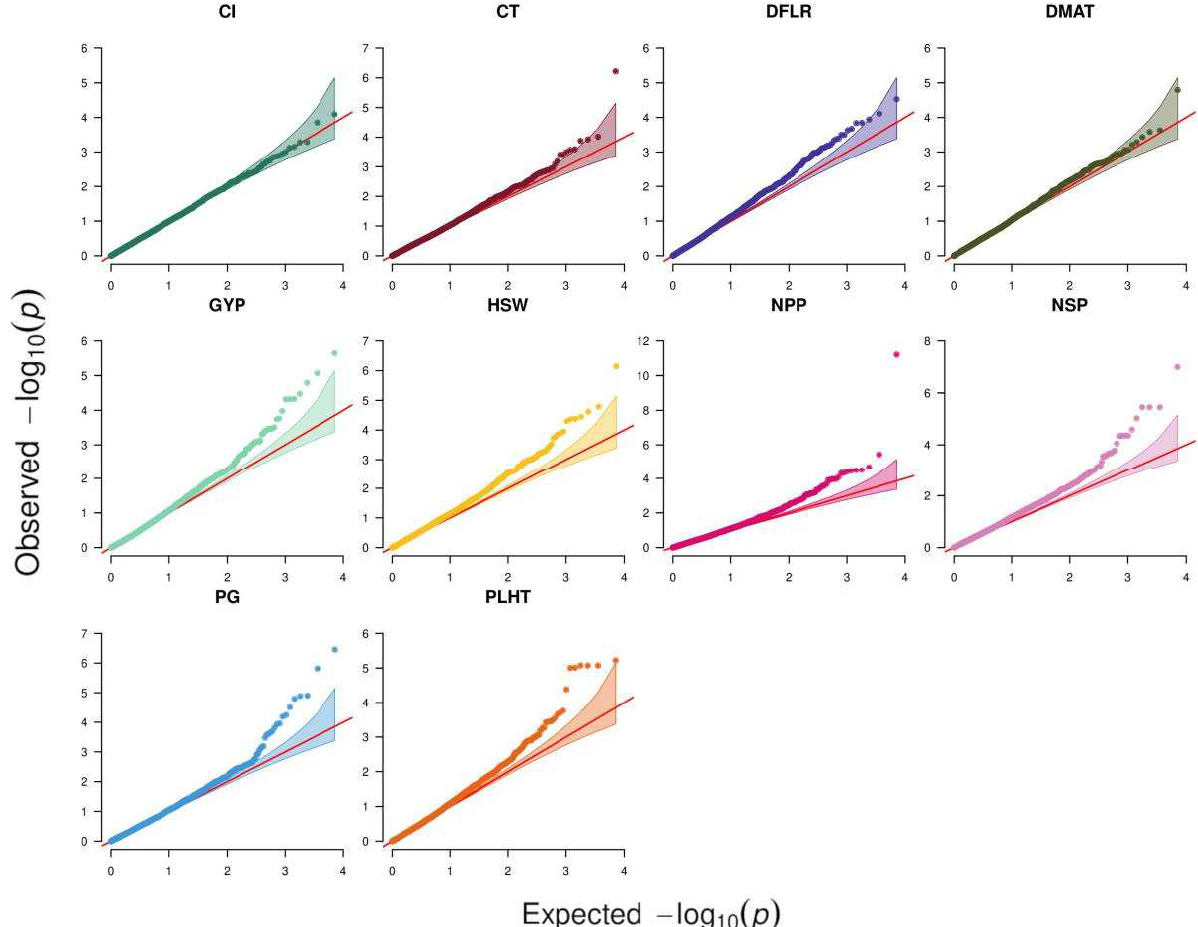
Figure 2. Q–Q plots of the chi2 statistics obtained from processing traits and genomic variations of the studied faba accessions. GY: grain yield per plant; DFLR: days to flowering after sowing; DMAT: days to maturity after sowing; PLHT: plant height; NPP: number of pods per plant; NSP: number of seeds per plant; HSW: hundred seed weight in g; PG: pollen germination under heat stress conditions with temperature above 32-degree Celsius; Cl: chlorophyll content. Table 6. SNPs detected in multi-trait genome-wide association study (MT-GWAS) with significant p -values. AF: allele frequency of allele1.